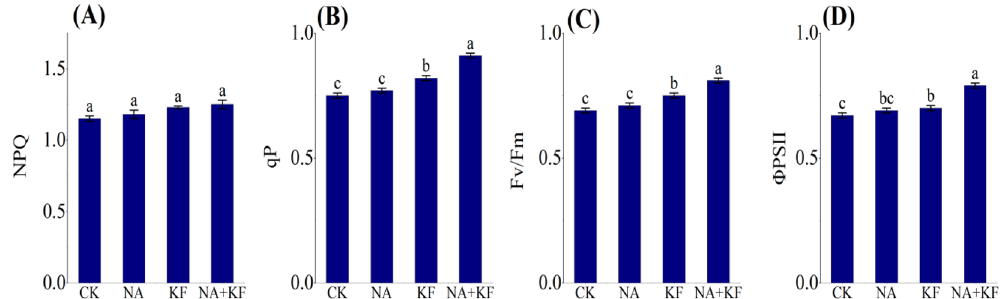
Figure 4. Effects of different treatments on chlorophyll fluorescence of tomato seedlings. ( A ) NPQ, ( B ) qP, ( C ) Fv/Fm, ( D ) ΦPSII, NA, 5 mg·kg −1 NA; KF, 60 mg·kg −1 KF; NA + KF, 5 mg·kg −1 NA and 60 mg·kg −1 KF. Different lowercase letters denote statistical differences among treatments of tomato seedlings at the 5% level according to LSD test. Error bars above mean indicate standard error (n = 3).